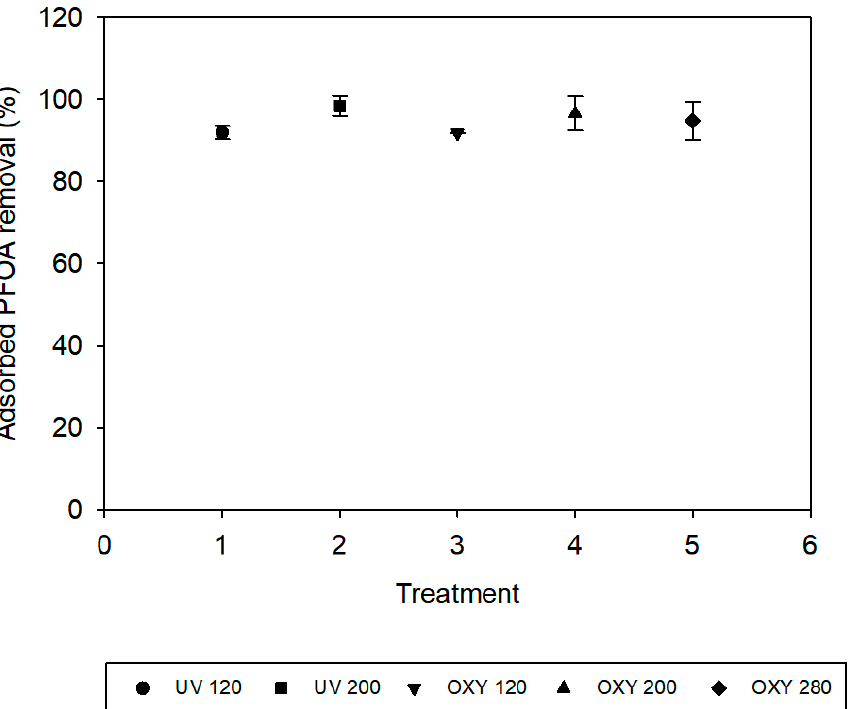
Figure 4. Removal of PFOA from the surface of the membrane after UV irradiation for two differ- ent periods of time, and after bubbling of oxygen for three different periods of time. periods of time, and after bubbling of oxygen for three different periods of